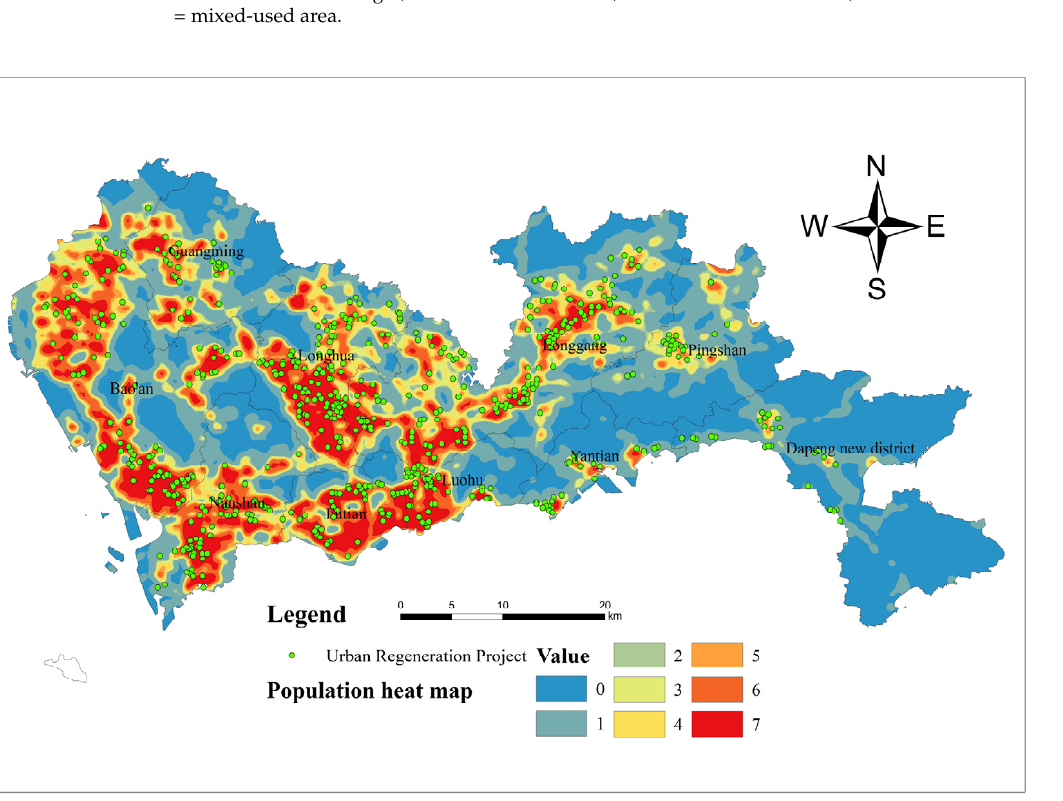
Figure 4. UR and population heat map. Table 7. Number of UR projects with different population heat values. Heat Value Classifica- tion